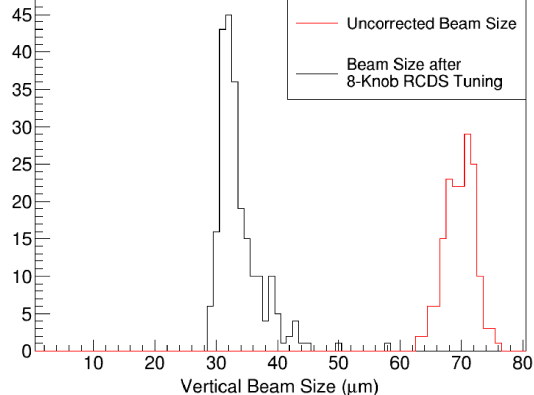
FIG. 5. Histogram of hundreds of experimental vertical beam size measurements both using the standard lattice for light-source operations with no additional tuning and after tuning with the RCDS algorithm using the best 8 eigenparameters. A clear improvement is observed. Note also the high-side tail of the low-beam-size distribution.